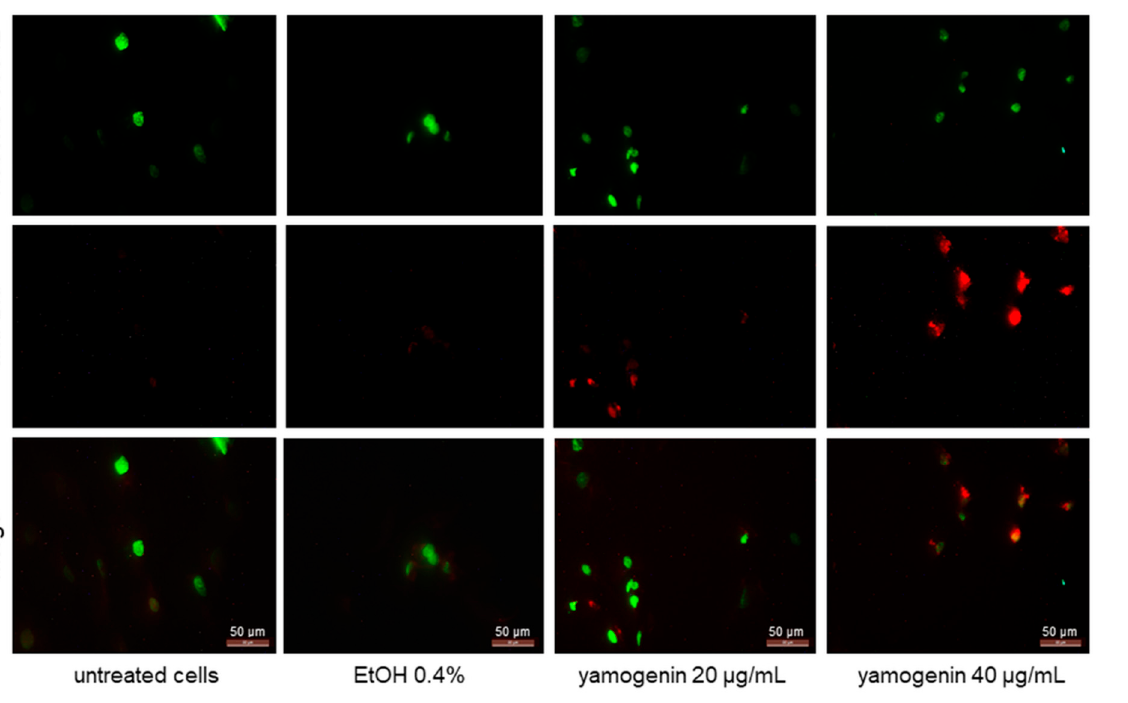
Figure 11. Yamogenin activates Bid in SKOV-3 cells. The cells were incubated with ethanol (0.4% ( v/v )—a control) and yamogenin at concentrations of 20 and 40 µg/mL for 24 h and then stained with primary anti-Bid antibody (1:300), secondary anti-rabbit IgG Alexa Fluor 594 antibody (1:1000, red fluorescence), and Hoechst 33342 dye (green nuclei). The results were observed under a fluorescent microscope at 400× magnification.